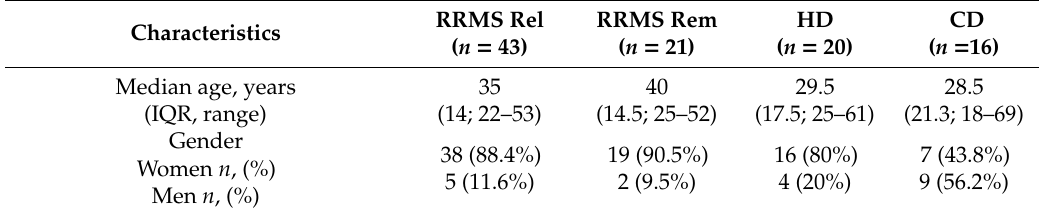
Table 1. Patients